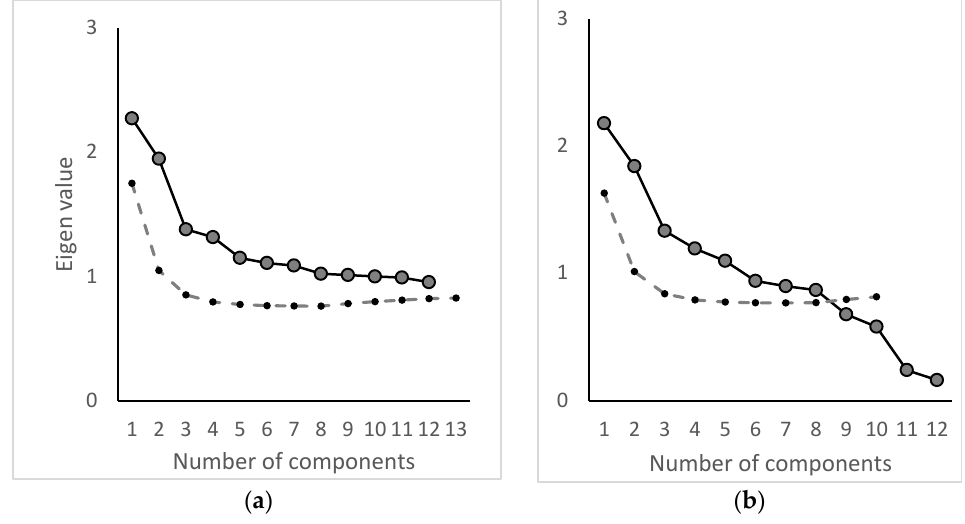
Figure 4. ( a ) Initial scree plot, where six factor components were retained. ( b ) Final scree plot, where five factor components were retained. The dotted line represents Horn’s parallel analysis. Table 1. Resulting factor pattern for the factor analysis for 2002–2011. Loading scores are marked in bold if they meet the criterion of >0.45 or < −